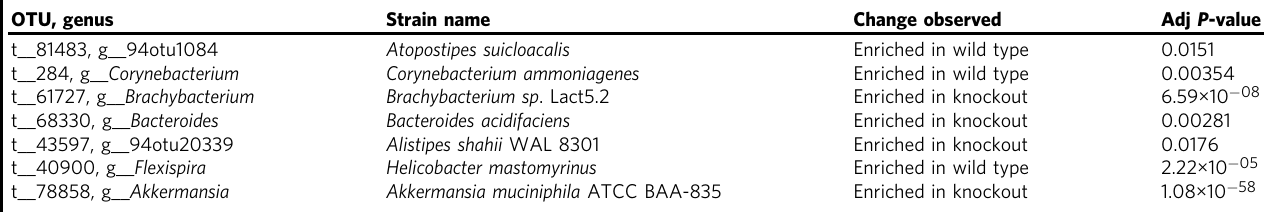
Table 1 OTUs identi fi ed at strain level in the microbiome of wt and Il36rn − / − mice OTU,